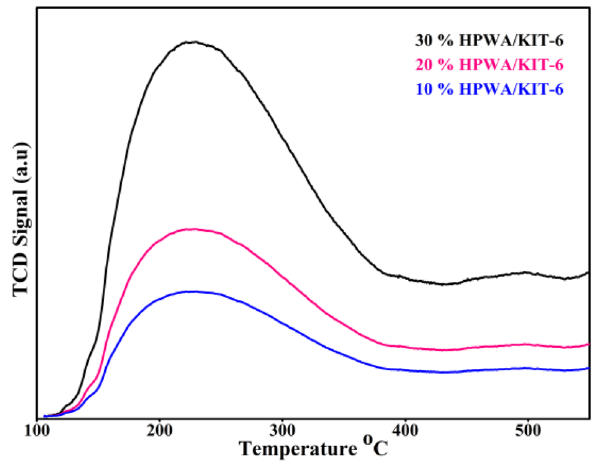
Fig. 3 Pyridine-adsorbed AT-FTIR spectra of KIT-6 and HPWA-sup- ported catalysts Fig. 4 Ammonia-TPD spectra of HPWA-supported KIT-6